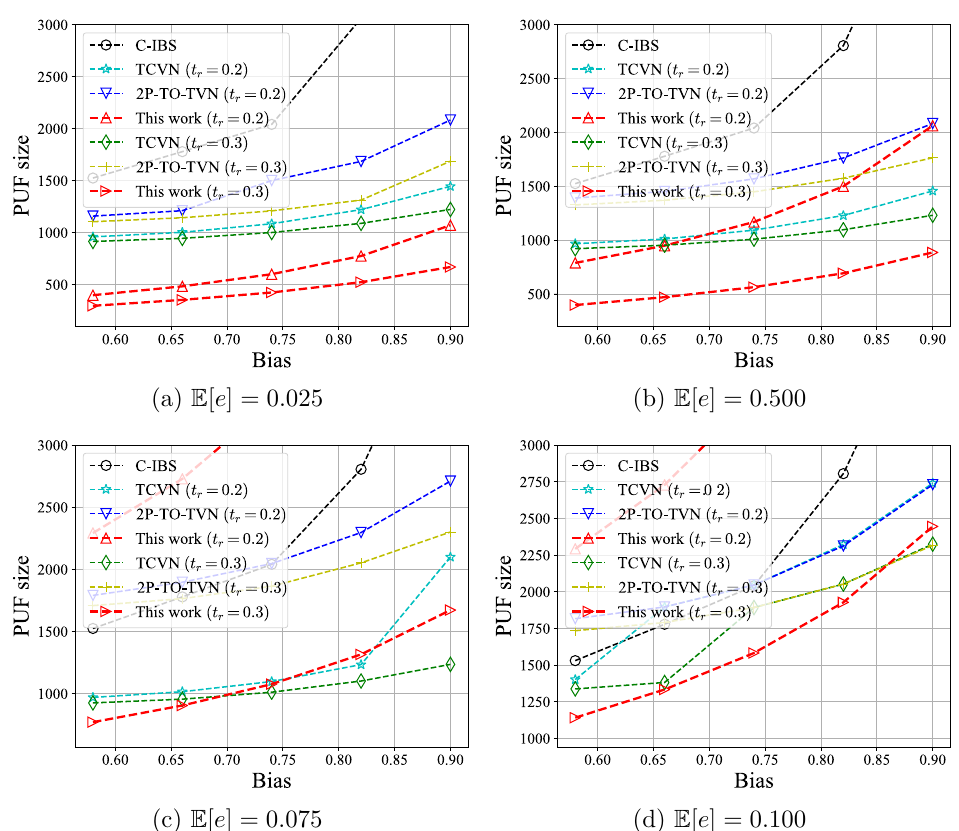
Figure 11: Comparison of FEs exploiting cell-wise